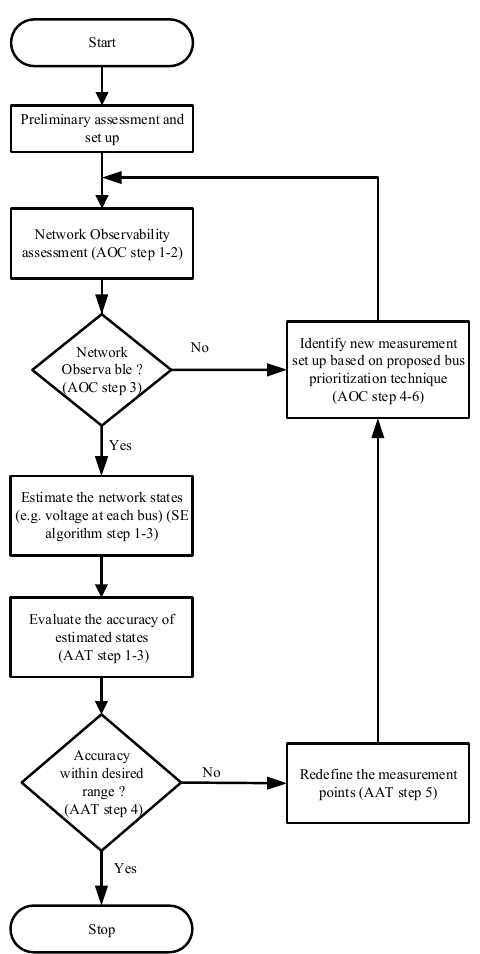
Figure 2. Compact algorithm for integrated assessment.